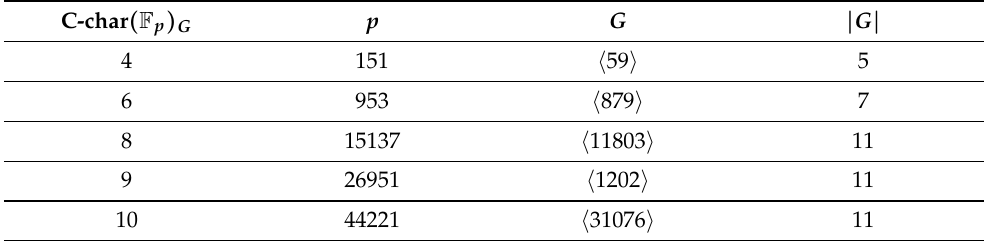
Table 2. Finite hyperfields of non-prime C-characteristic ≤